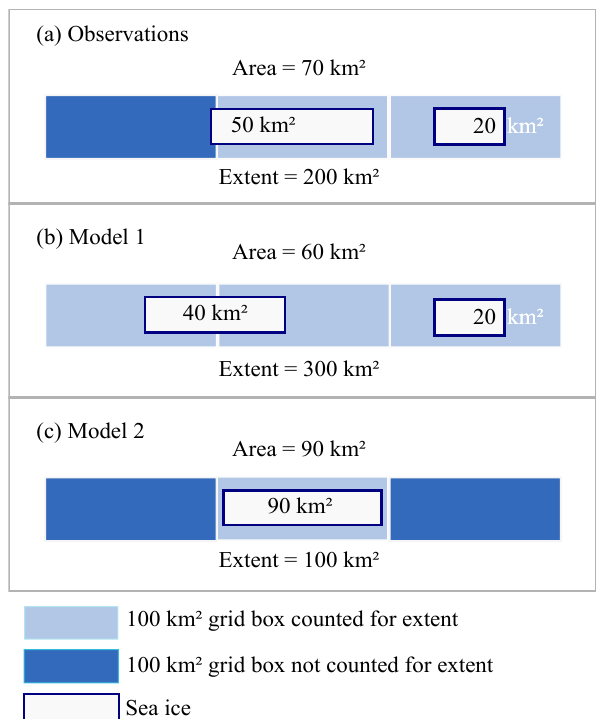
Fig. 1. A fictitious example to illustrate the possible non-intuitive relationship between sea-ice area and sea-ice extent. (a) In the ob- servations, the ice pack is distributed such that two grid cells are covered by more than 15% ice. (b) In a fictitious model simulation, less sea ice than in the observations is distributed such that three grid cells are covered by more than 15% ice. (c) In a fictitious model simulation, more sea ice than in the observations is distributed such that only one grid cell is covered by more than 15%